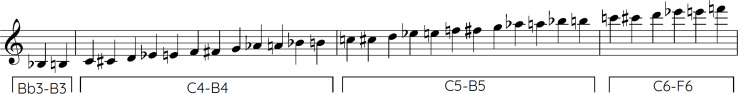
Range of stimuli.Diagram depicting the range of pitches from B♭3 to F6 included in the current study. This corresponds to the standard range of the oboe (while the oboe can play higher than F6, occurrences of these higher pitches are extremely rare in most musics).